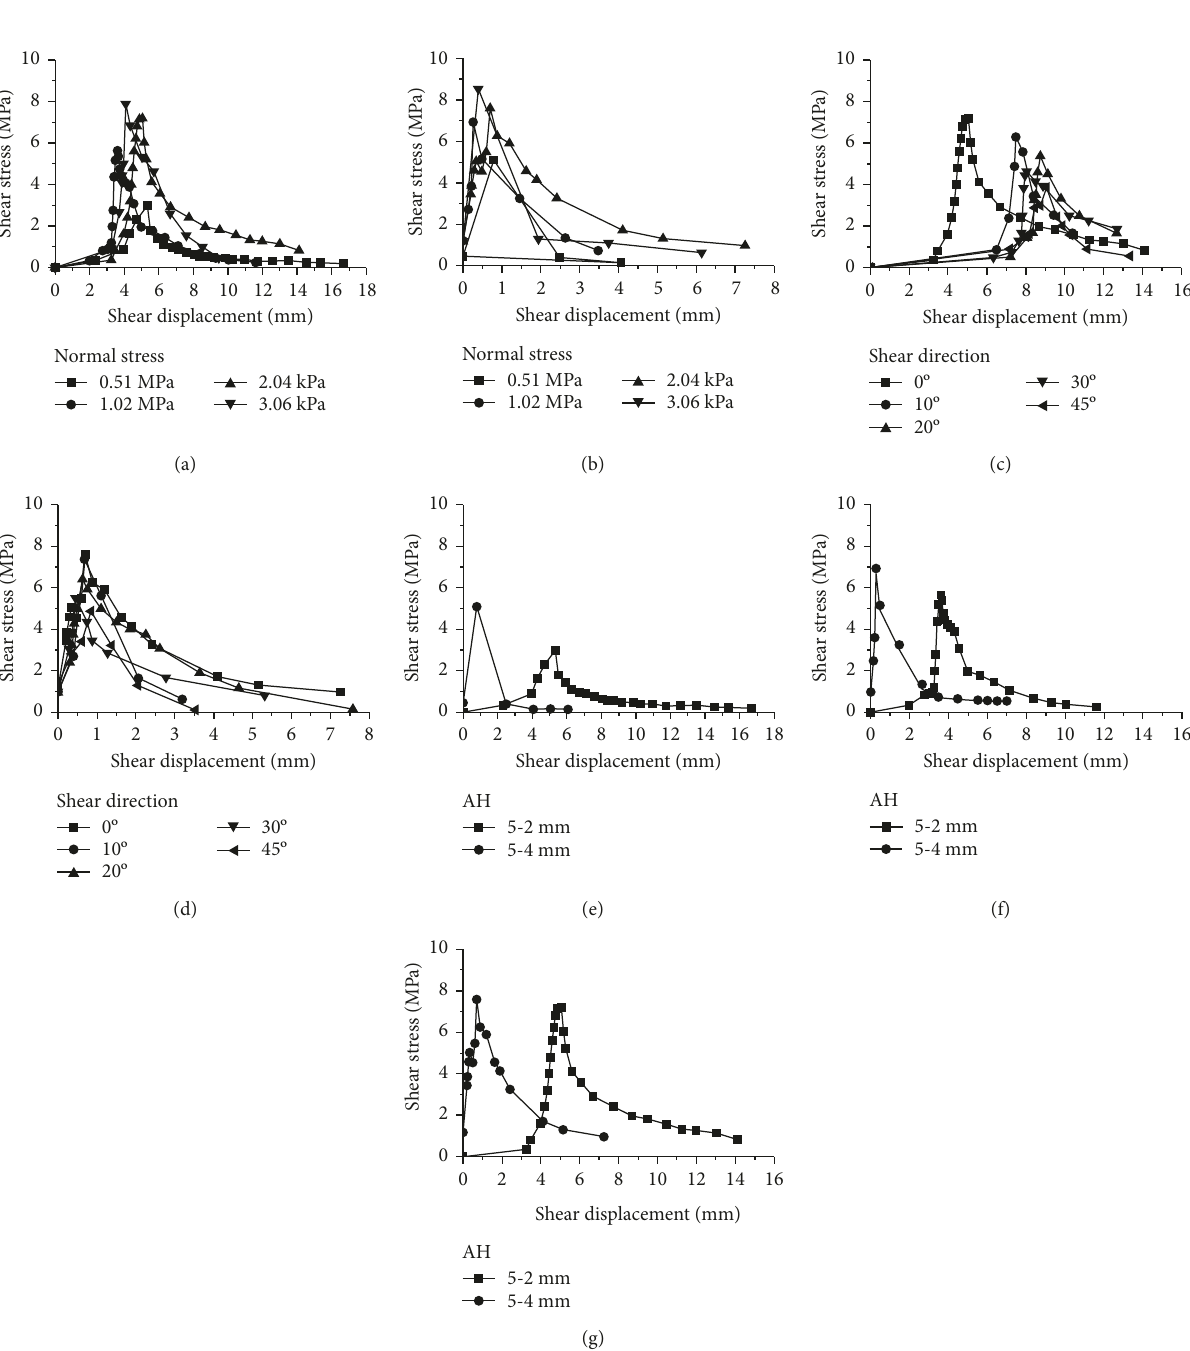
5-2 mm and SD (cid:31) 0.51MPa and SD (cid:31)